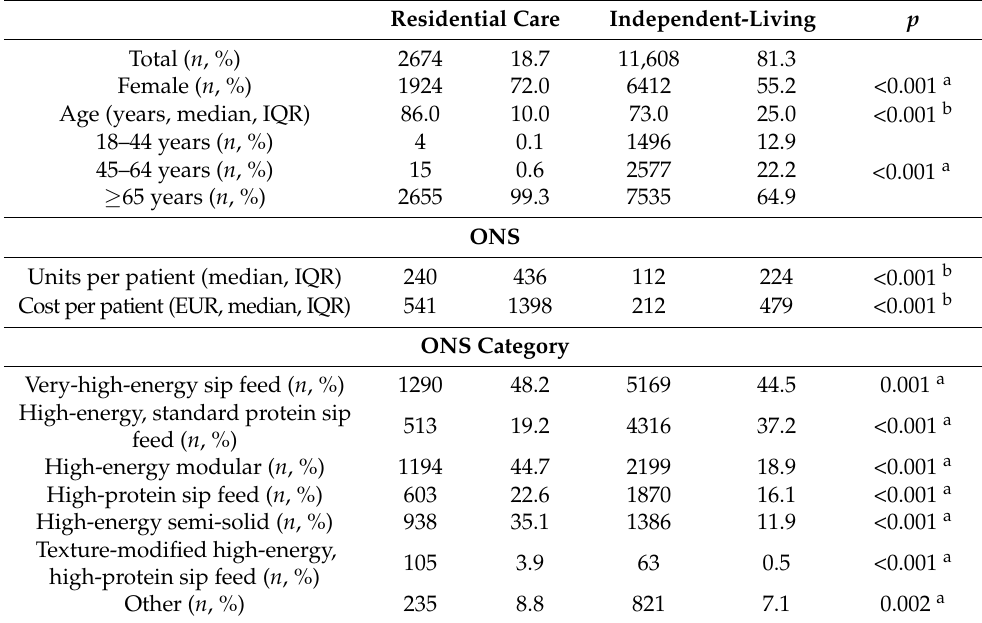
Figure 1. Breakdown of oral nutritional supplement products dispensed across categories in the full cohort ( n = 14,282). Table 3. Comparison of characteristics and oral nutritional supplement dispensing between patients living in residential care and living independently across a 12-month